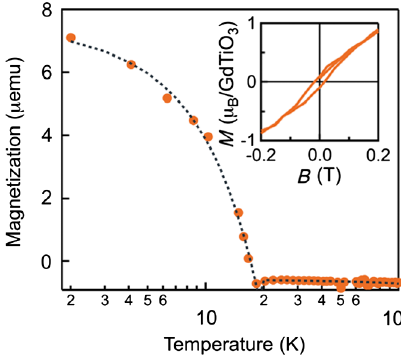
FIG. 2. Magnetization as a function of temperature at 10 mT for a 4-nm GdTiO 3 = 1 - nm SrTiO 3 = 4 - nm GdTiO 3 = LSAT hetero- structure. The dotted line is a guide to the eye. The inset shows the magnetization M as a function of magnetic field at 2 K.